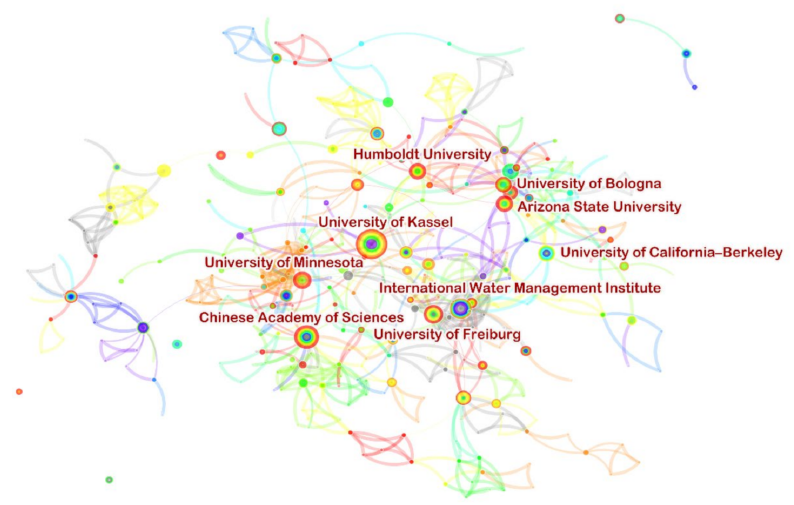
Figure 3. The influence of institutional cooperation in the field of urban agriculture from 2001 to